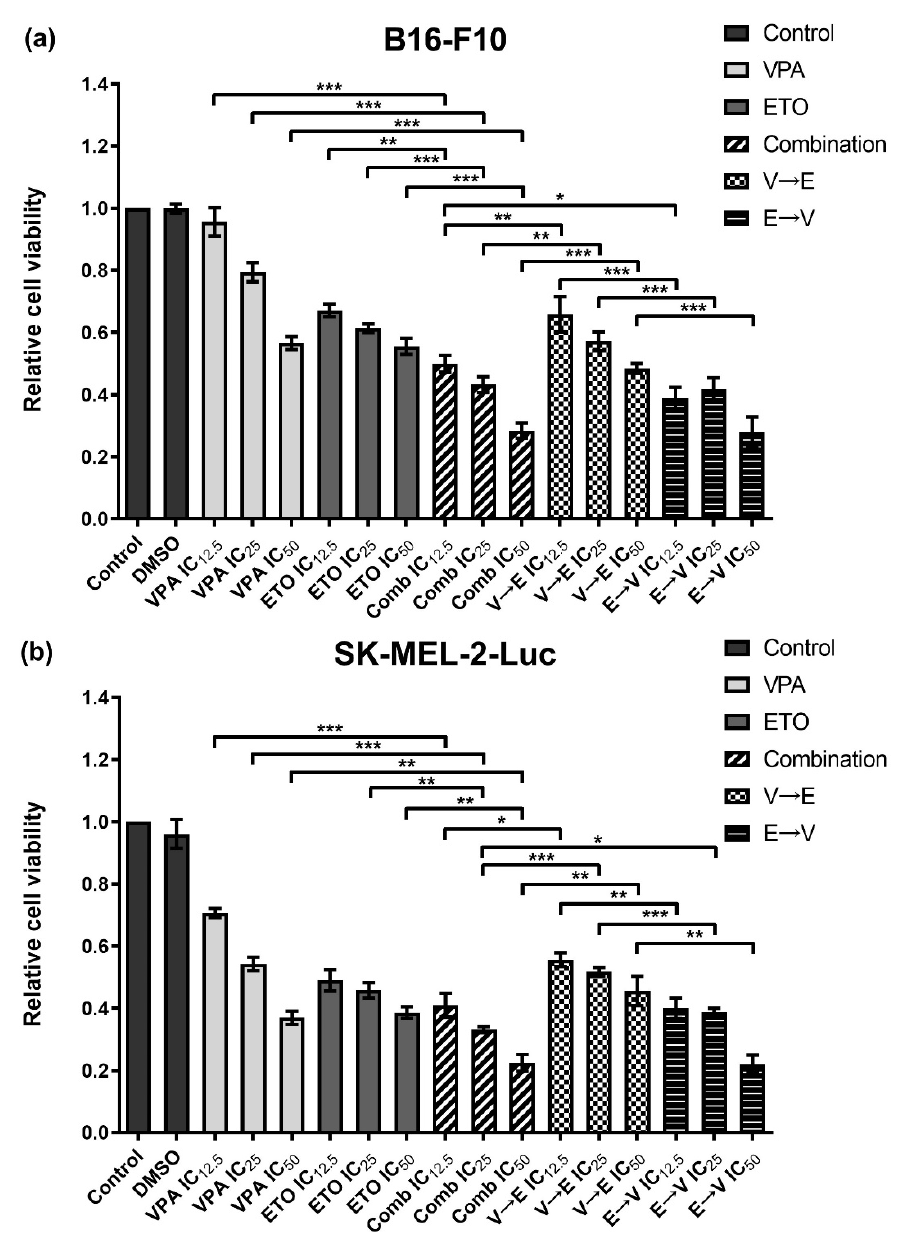
Figure 3. Inhibition effects of single versus combination treatments of VPA and ETO on melanoma cells. The relative cell viability was evaluated after 72 h single, simultaneous, or sequential combined treatments of VPA and/or ETO on ( a ) B16-F10 and ( b ) SK-MEL-2-Luc cells at the corresponding IC 12.5 , IC 25 , and IC 50 determined in Figure 2. The data are shown as means ± SEM of independent experiments in triplicate. (* p < 0.05; ** p < 0.01; *** p < 0.001).